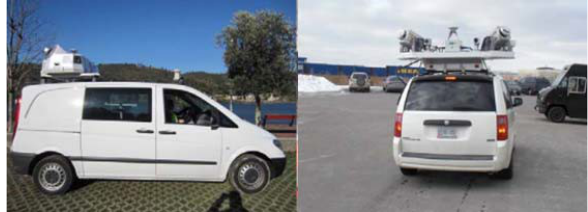
Figure 2. Mobile LiDAR System used for the survey.